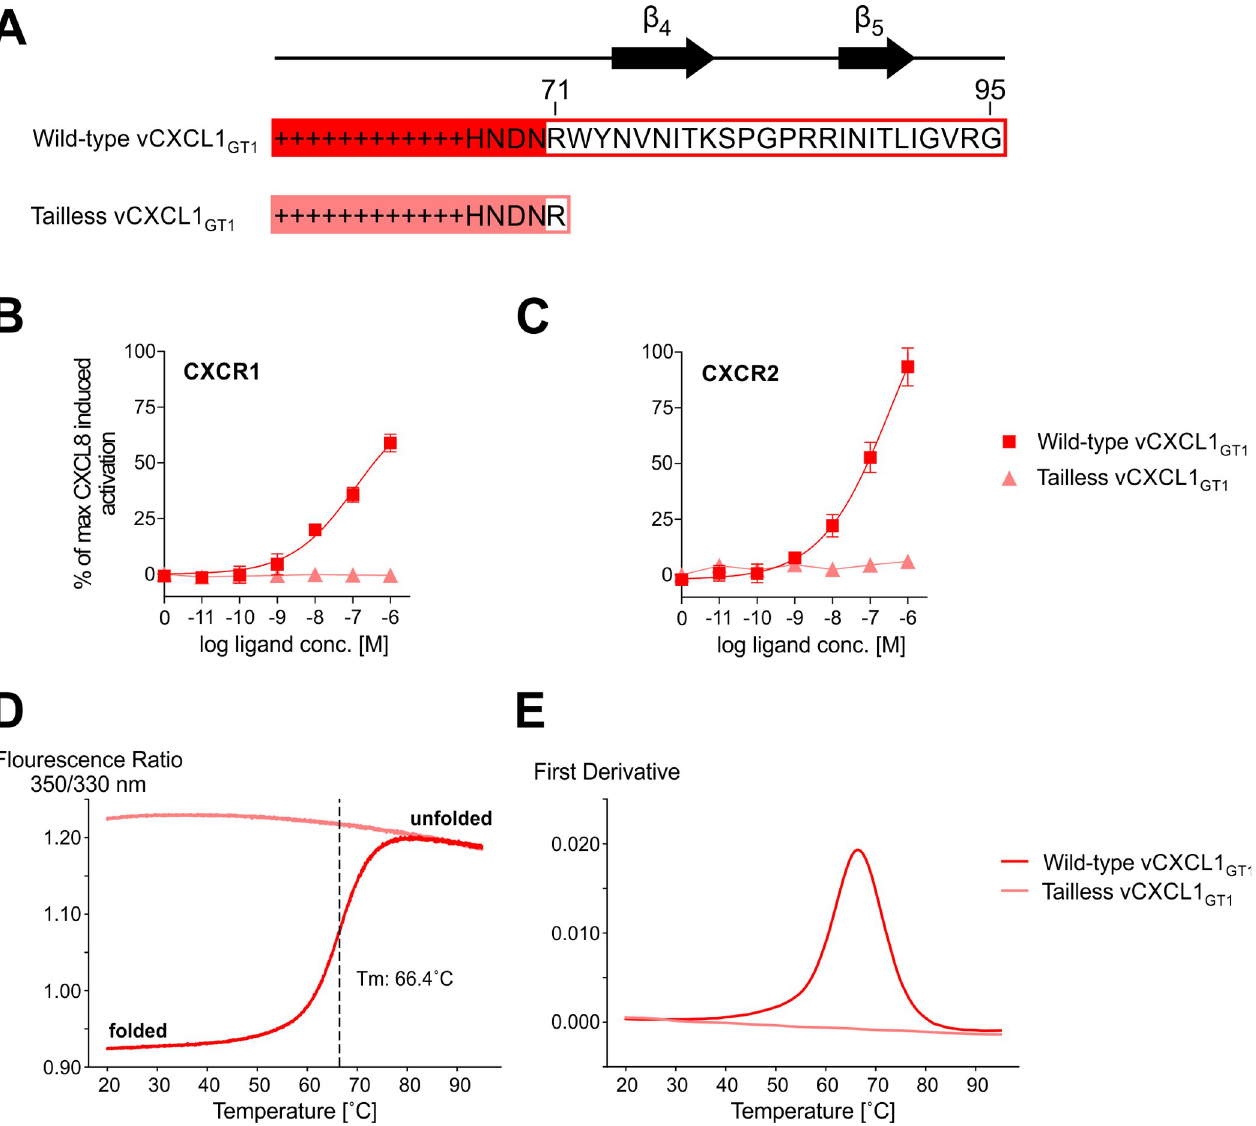
Fig 8. Functional activity and thermal melting curves for tailless and wild-type vCXCL1 GT1 . (A) C-terminal sequences and secondary structure of wild-type and tailless vCXCL1 GT1 . (B+C) G protein signaling in an IP accumulation assay of wild-type and tailless vCXCL1 GT1 on CXCR1 and CXCR2; n = 3. Error bars shown as SEM. (D+E) Thermal melting curves and their first derivative for wild-type and tailless vCXCL1 GT1 ; n = 3.